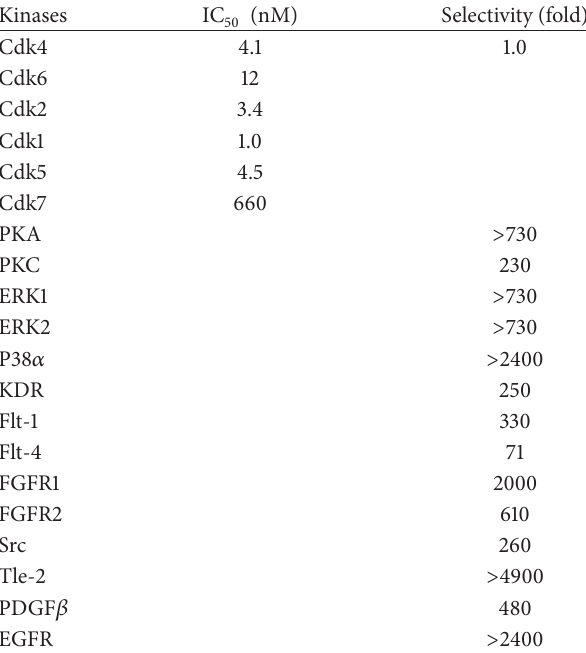
Table 11: Enzyme inhibition activity of compound 79 against the Cdk family and other kinases.